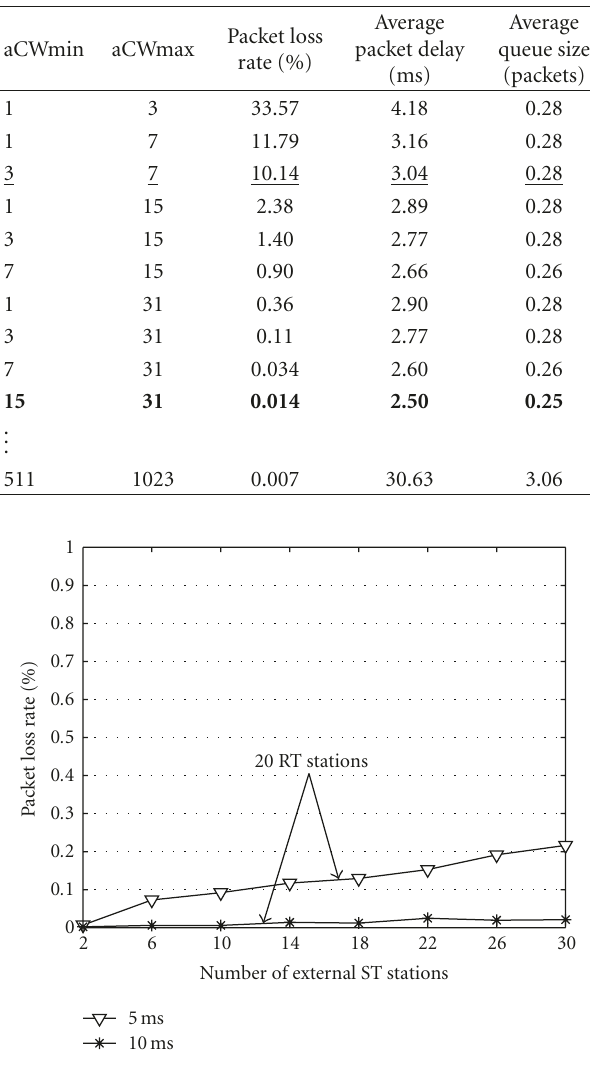
Figure 9: Packet loss rate—MSP = 5ms and 10ms.